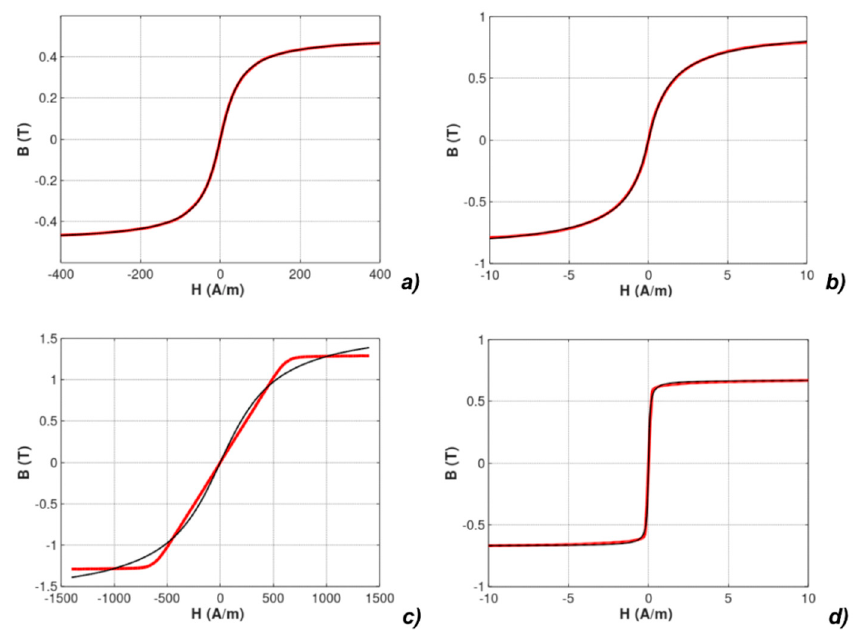
Figure 5. Results of modeling the anhysteretic curve using the arctan-based function (measurements: red line, modeling: black line): ( a ) Mn-Zn ferrite F3001, ( b ) Co 67 Fe 4 Mo 1 B 11 Si 17 amorphous alloy, ( c ) Fe 73.5 Cu 1 Nb 3 Si 15.5 B 7 nanocrystalline alloy with perpendicular anisotropy, ( d ) Fe 67 Co 18 B 14 Si 1 amorphous alloy with parallel anisotropy.